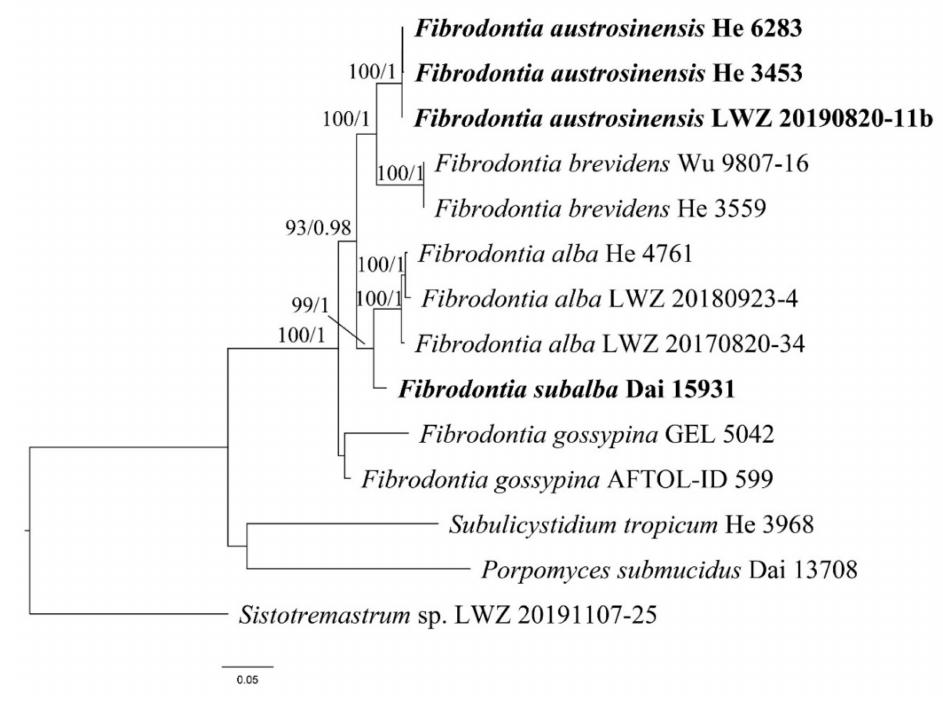
Figure 2. Phylogenetic position of Fibrodontia austrosinensis and F. subalba inferred from the data set of ITS, 28S, tef1 α , and rpb2 region. The topology is from maximum likelihood analysis. Bootstrap values and Bayesian posterior probabilities, if simultaneously above 50% and 0.8, respectively, are labelled at the nodes. The newly described species are in boldface.